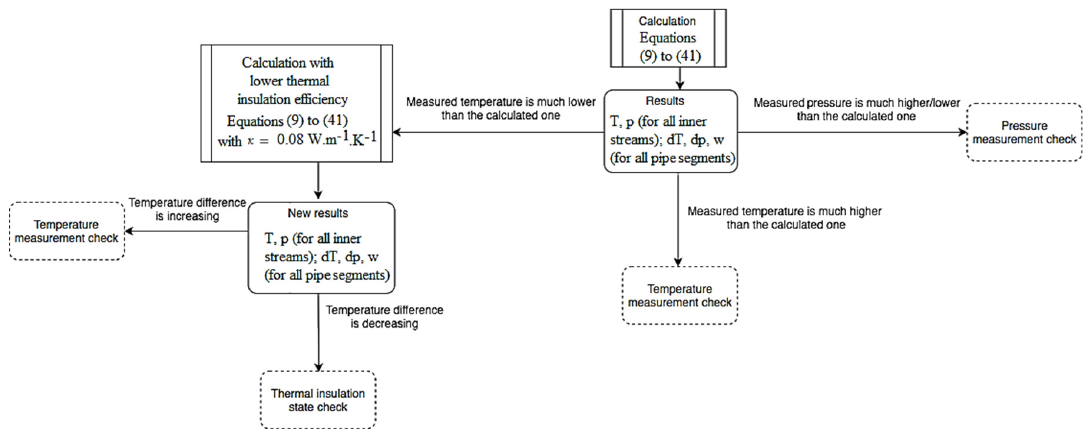
Figure 10. Algorithm used to formulate recommendations for steam system inspections and metering devices check.